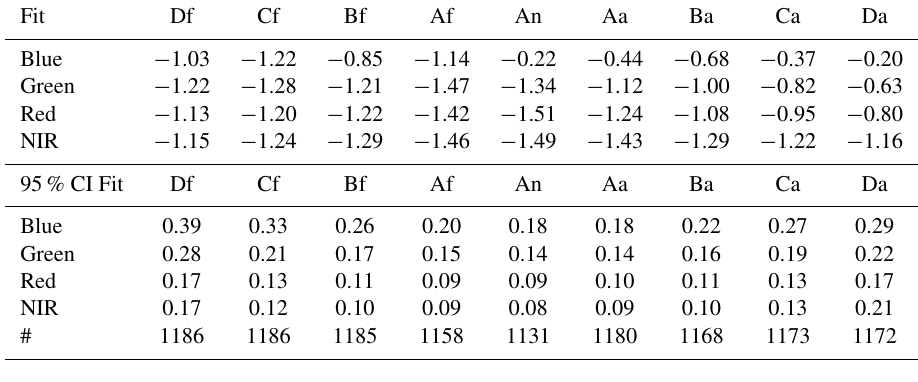
Table A1. Decadal trend values (in percent) aggregated over three stable desert sites for the 36 MISR channels. The first four rows present the decadal trends for all four MISR wavelengths and nine cameras. The second four rows represent the 95% confidence intervals (CI) for the corresponding trends. The final row gives the number of events for each camera.